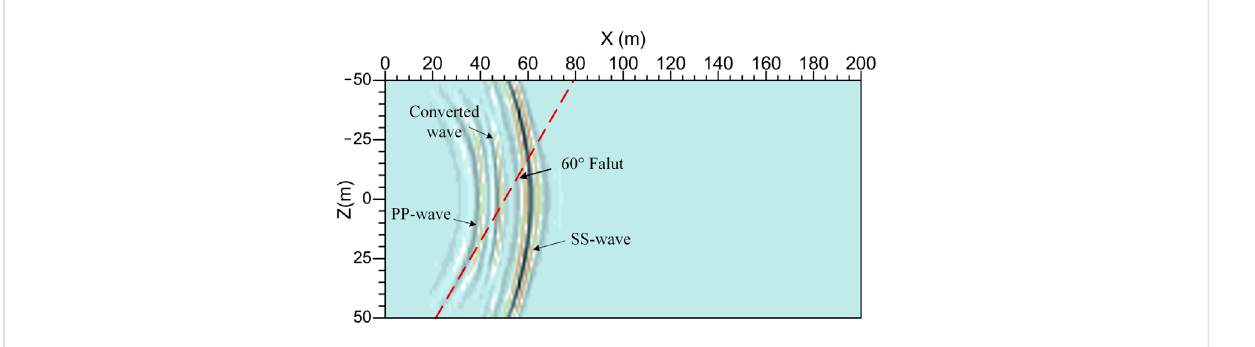
FIGURE 6 Conventional EOM section of the rock roadway 60 ° dip fault